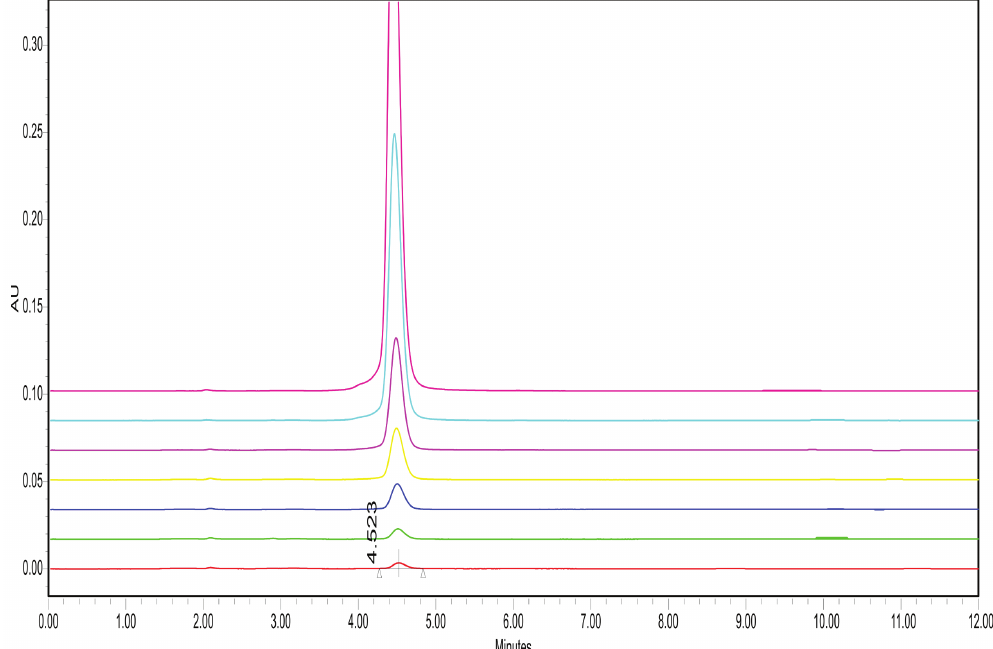
FIGURE 1 - Overlay of representative chromatograms of